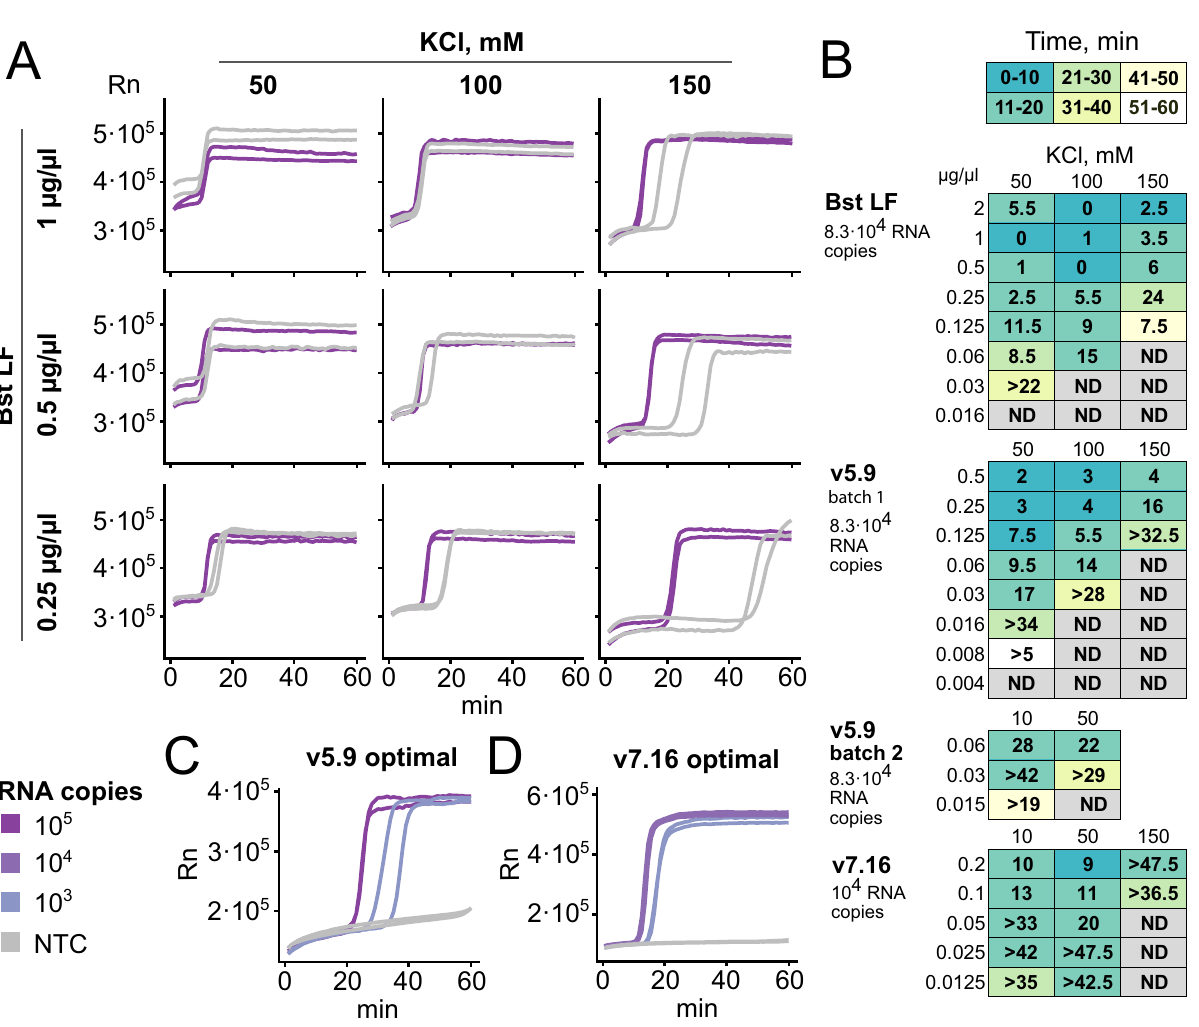
Figure 1. Optimization of enzyme amount and buffer composition for RT-LAMP. All experiments shown were set up with iLACO primers and run for 1 h at 65 °C in a thermocycler, tracked by either SYBR Green I (Bst LF, v5.9) or Eva Green (v7.16) fluorescence. ( A ) Example of RT-LAMP optimization varying Bst LF amount and the KCl concentration. Positive control synthetic RNA (83,000 copies) and no template control (each in duplicate) were assayed. ( B ) Summary of optimization of enzyme amount and KCl concentration for Bst LF, v5.9, and v.7.16. Numbers indicate the time difference between the slowest-amplifying positive control replicate and the fastest-amplifying negative control replicate. Color indicates the required time to detect the slowest-amplifying positive control. See Fig. S1 for a additional details regarding how tables are contructed. “ > …” indicates that the negative control did not amplify within 1 h. ND indicates no amplification of either positive or negative control. Two batches of v5.9 with differing activity were assayed, and batch 2 was used for further experiments. ( C–D ) Optimal conditions determined for v5.9 (0.03 µg/µl in ThermoPol buffer, 10 mM KCl) and v7.16 (0.025 µg/µl in isothermal amplification buffer, 50 mM KCl). 83,000 and 830 copies of RNA were used with v5.9, 10,000 and 1000 with